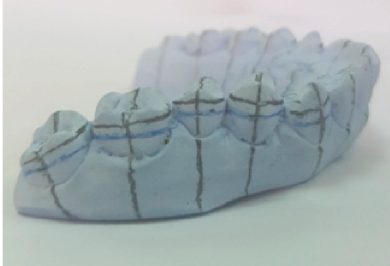
Figure 1: Horizontal and vertical reference lines.